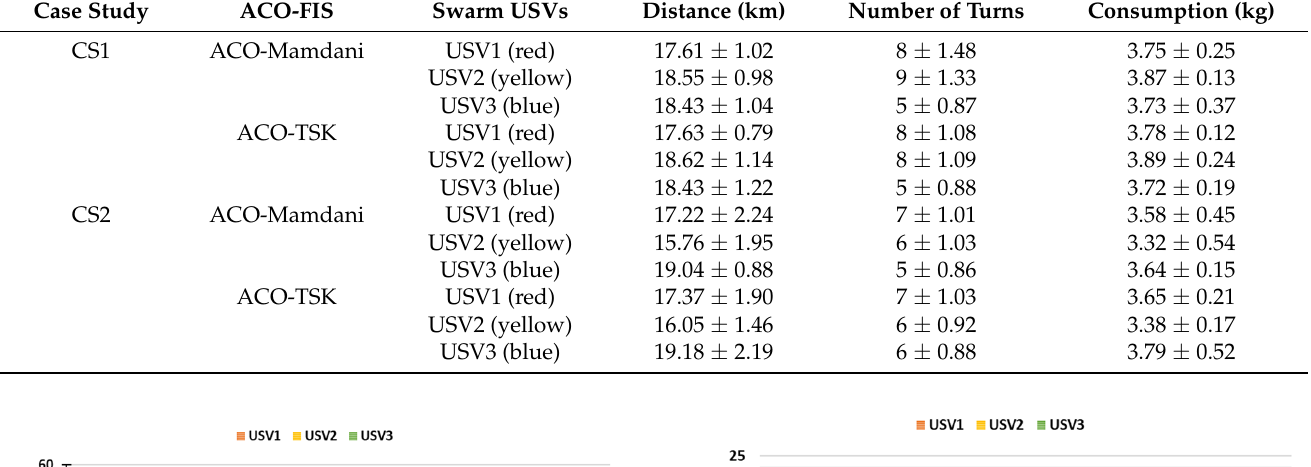
Table 3. Path planning mean results with standard deviation after 20 runs of the case studies for each ACO-FIS approach for the swarm of USVs. The number of turns are rounded. The best solutions are denoted in bold.